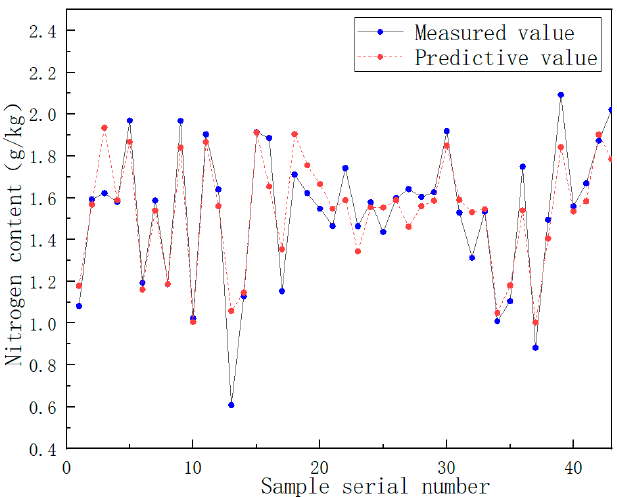
Figure 14. Comparison of the predicted value of nitrogen content in the test set with the measured